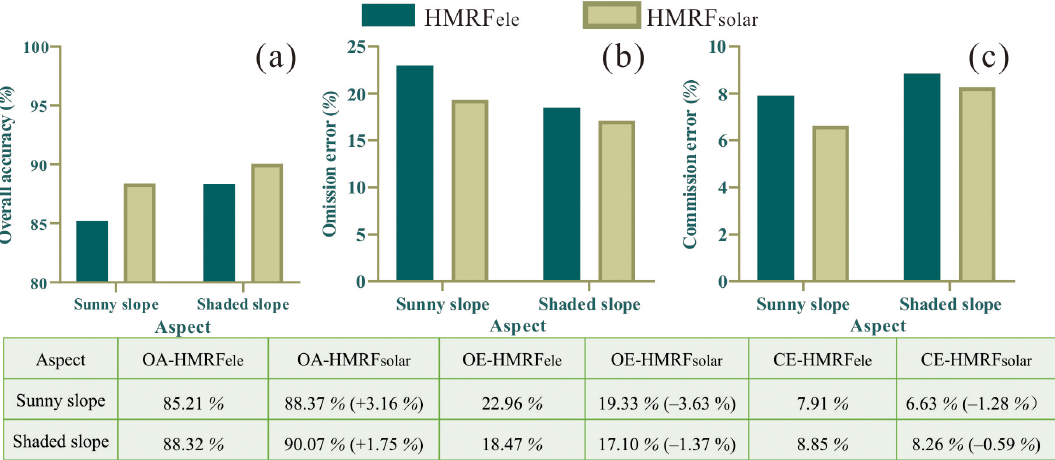
Figure 7. Effect of aspect on OA (a) , OE (b) , and CE (c) of HMRF ele - and HMRF solar -based snow products from 2002–2021.